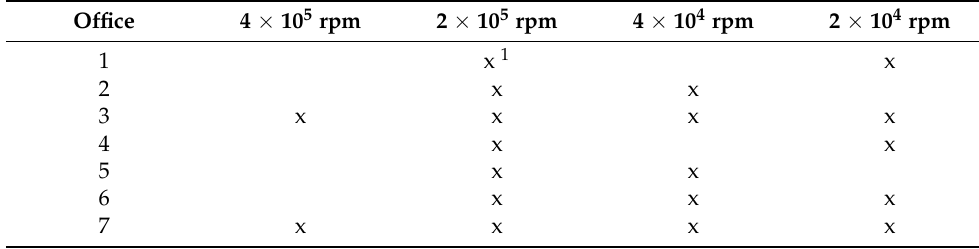
Table 3. Handpieces used in the different examined dental offices (speed in rounds per minute